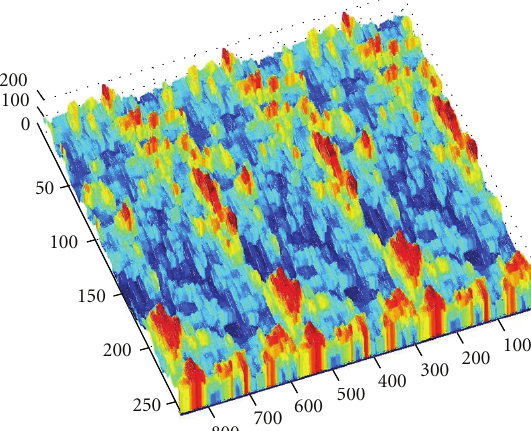
Figure 14: The constructed turbulence kinetic energy distribution surface of scattered data interpolation in high-pressure reversing valve runner.